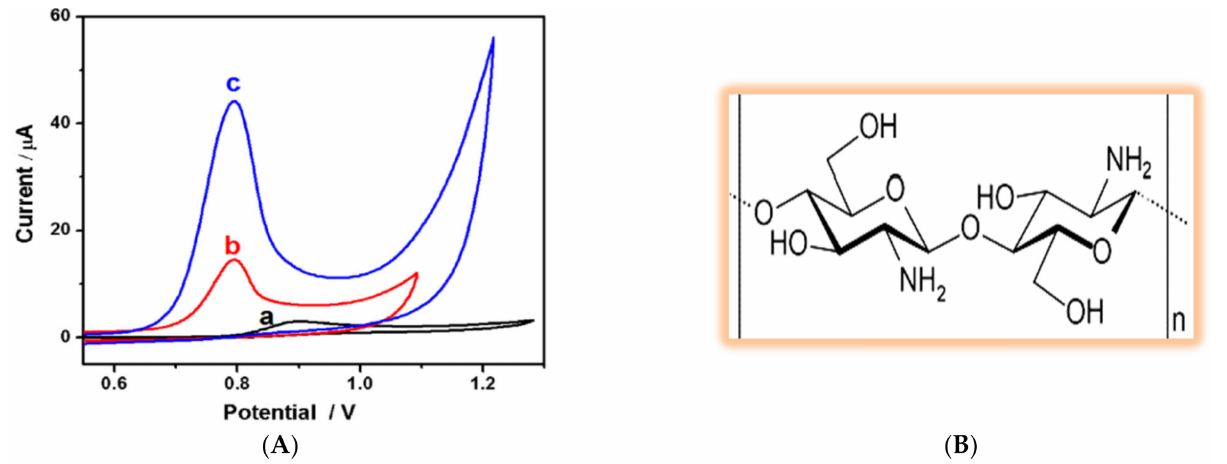
Figure 9. ( A ) Cyclic voltammograms of 100 µ M tryptophan (in 0.1 M PBS pH 4.0) at (a) bare GCE, (b) electrochemically activated bare GCE and (c) chitosan-modified GCE. Reprinted with permission from ref. [42]. Copyright 2015 Elsevier. ( B ) The chemical structure of